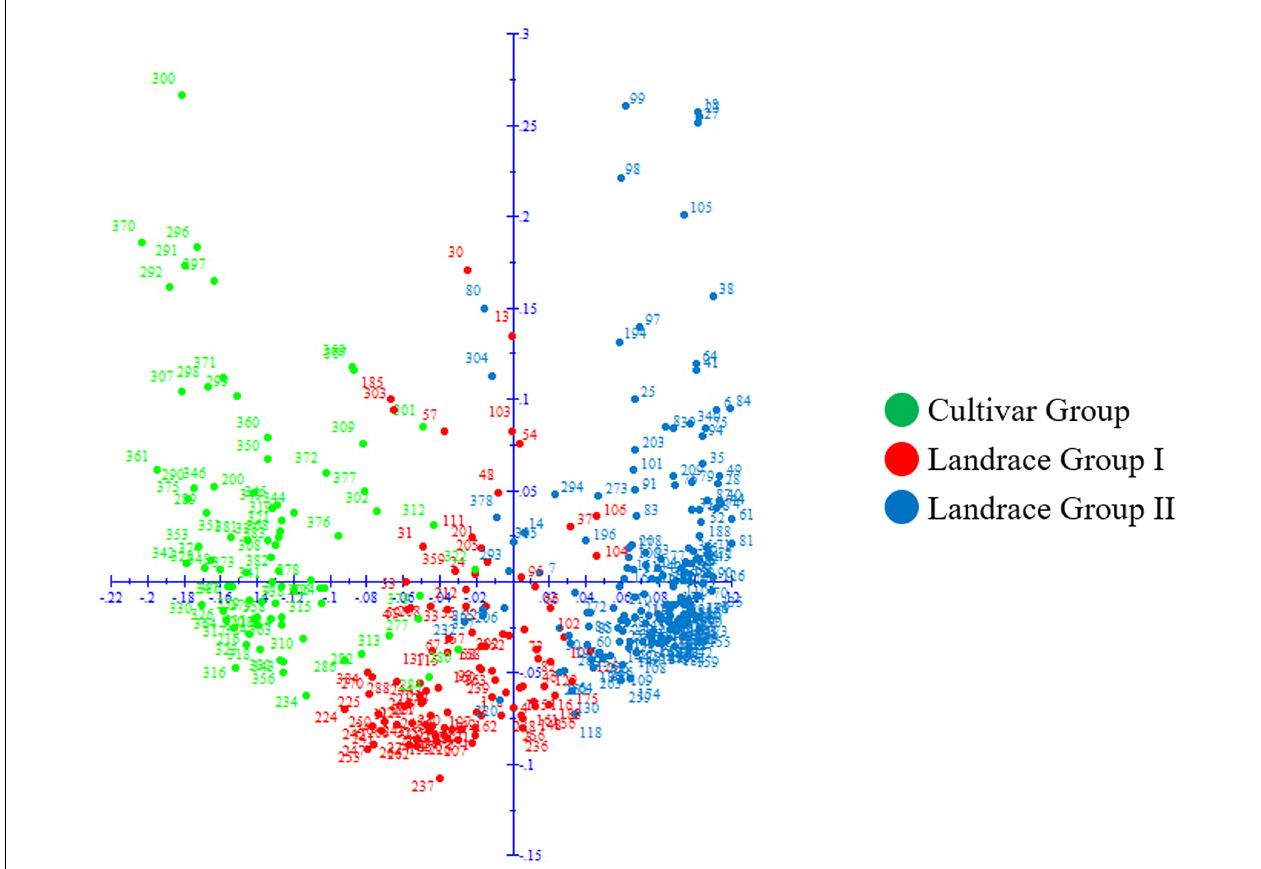
FIGURE 7 | Principal coordinate analysis (PCoA) of 369 Iranian hexaploid wheat accessions based on 16506 SNP markers. Colors reflect groupings derived from structure analysis.